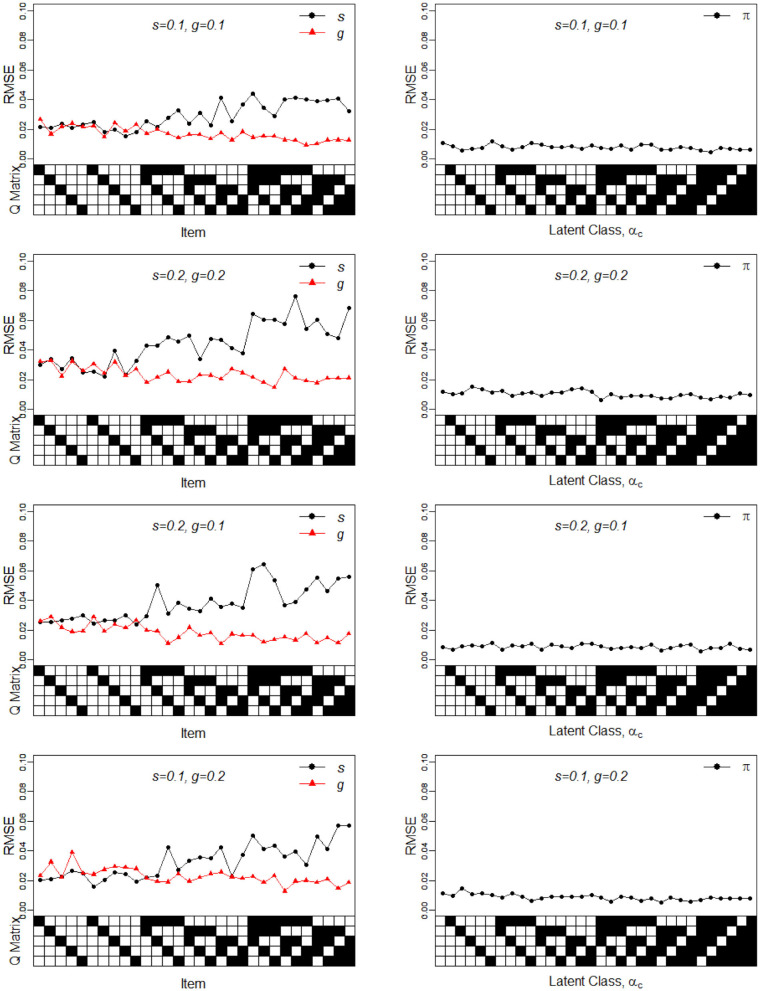
RMSE of the slip, guessing, and the latent membership parameters under four different noise levels. Given on the X-axis are the Q-matrix and αc, where a black square denotes the presence of the attribute.